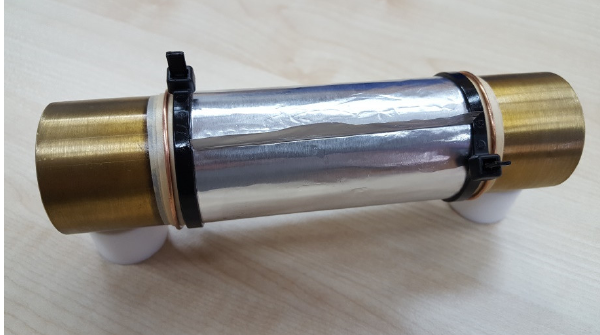
Figure 2. A photograph of the insulation sample prepared for testing.